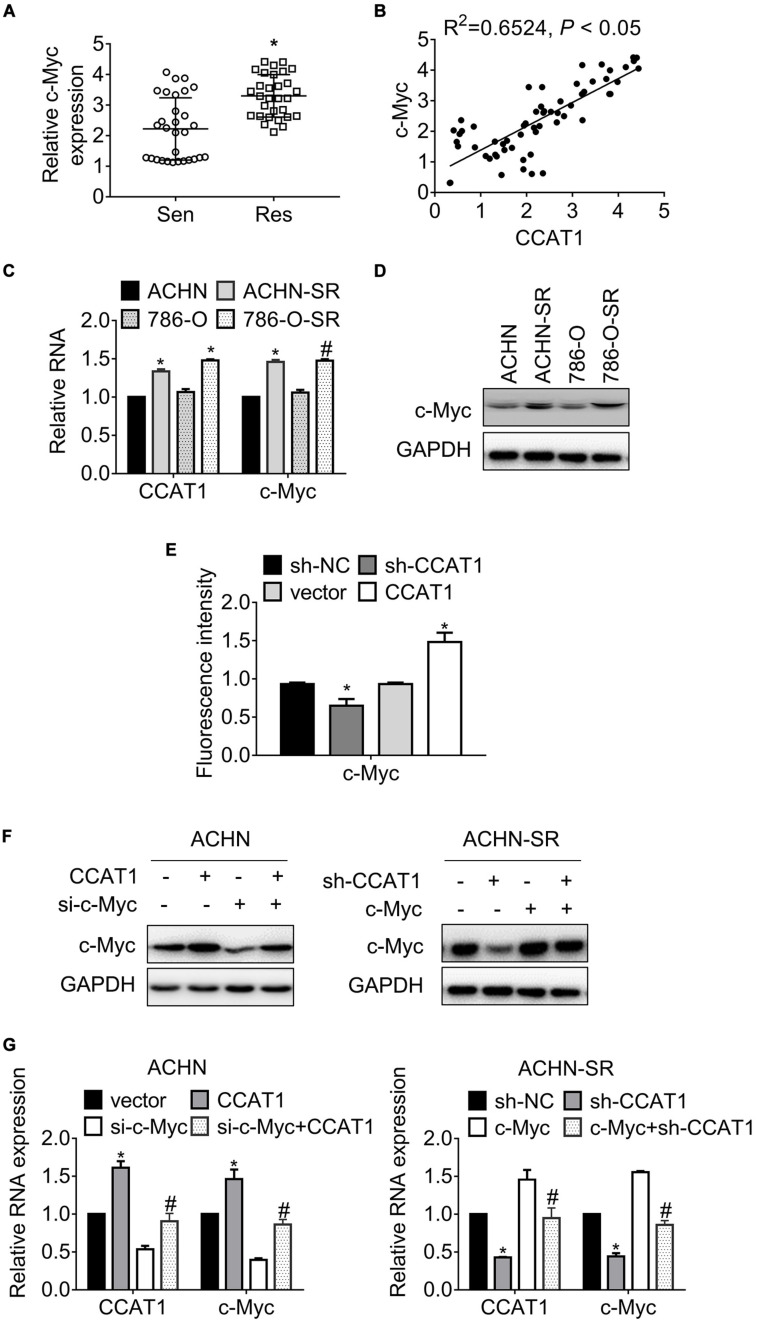
LncRNA CCAT1 promotes c-Myc expression. (A) The expression of c-Myc in sunitinib-sensitive or resistant RCC specimens were accessed by RT-qPCR. *P < 0.05 vs. sensitive groups. (B) The correlation of CCAT1 and c-Myc expression was estimated by Pearson’s correlation coefficient. P < 0.05 was considered statistical significance. (C) The expression of c-Myc in sunitinib-resistant and parental cell lines were accessed by western blot. *P < 0.05 vs. parental cells. (D) The expression of c-Myc in various RCC cell lines was accessed by western blot. *P < 0.05 vs. HK-2 cells. (E) The relative activity of MYC promoter was accessed by dual-luciferase assay. *P < 0.05 vs. vector or sh-NC. (F) The expression of c-Myc in the indicated cells were determined by western blot. *P < 0.05, vs. vector or sh-NC. (G) The expression of c-Myc in the indicated cells were determined by RT-qPCR. *P < 0.05 vs. vector or sh-NC. #P < 0.05 vs. si-c-Myc or si-c-Myc. Results represented the mean ± SD of three independently repeated experiments.